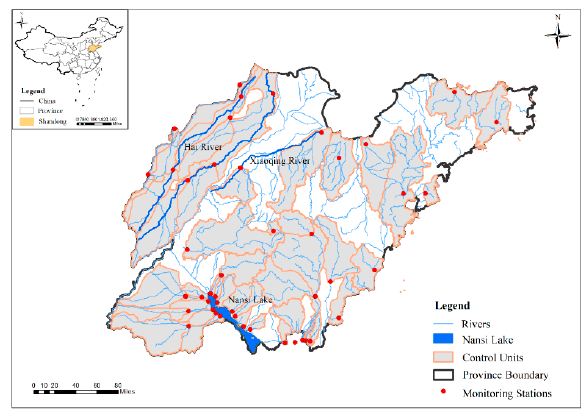
Figure 1. Location of water quality monitoring stations and control